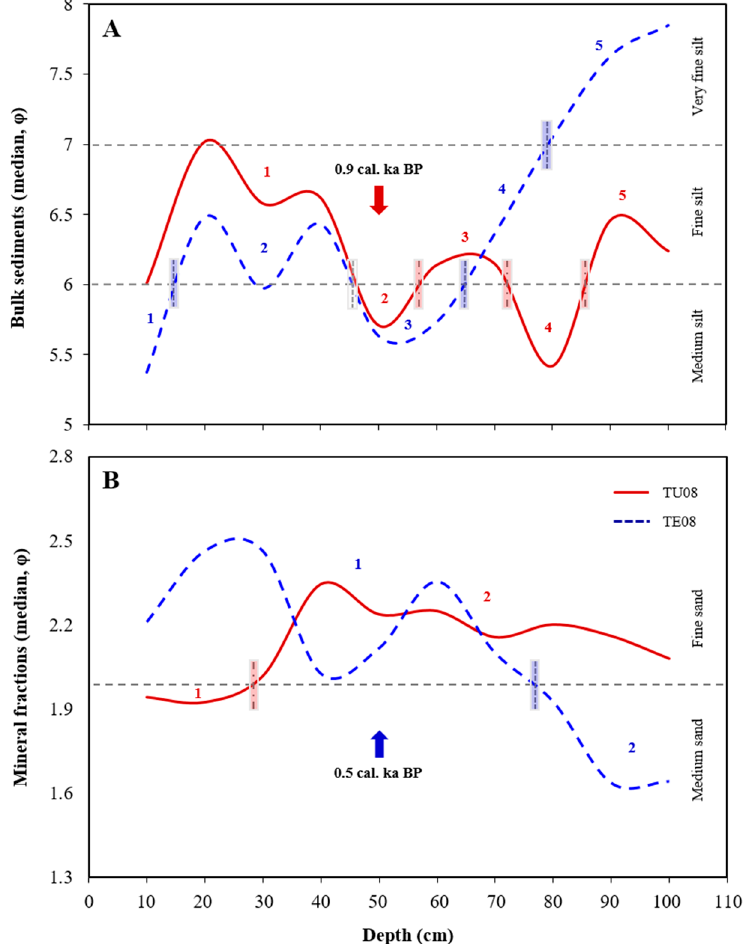
Figure 3. Grain size distributions of ( A ) bulk sediments and ( B ) mineral fractions in the peat deposits for the cores TE08 and TU08 with the ages. Numbers indicate periods of grain size changes implying sedimentation events, and gray-scale bars indicate the events’ borderline.